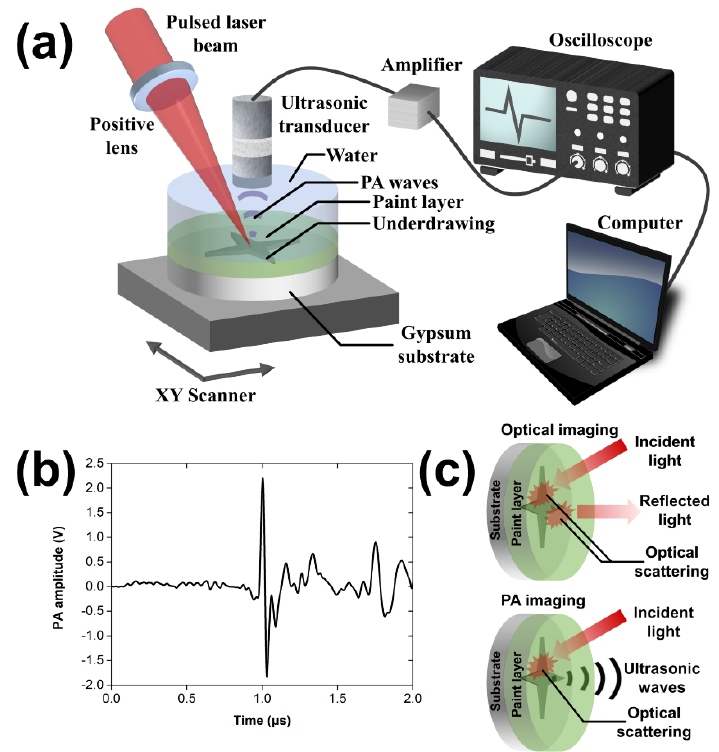
Figure 1. ( a ) Three-dimensional scheme of the reflection-mode photoacoustic (PA) imaging apparatus; ( b ) typical PA signal recorded in the time domain; ( c ) principle of optical and PA imaging for the detection of hidden underdrawings.